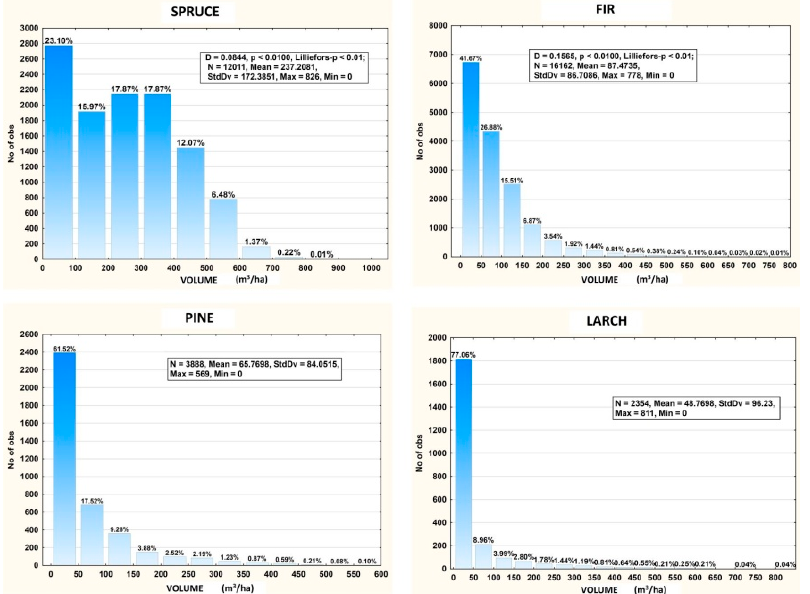
Figure 6. Distribution of stand elements based on volume for resinous species located in Southern Carpathians.